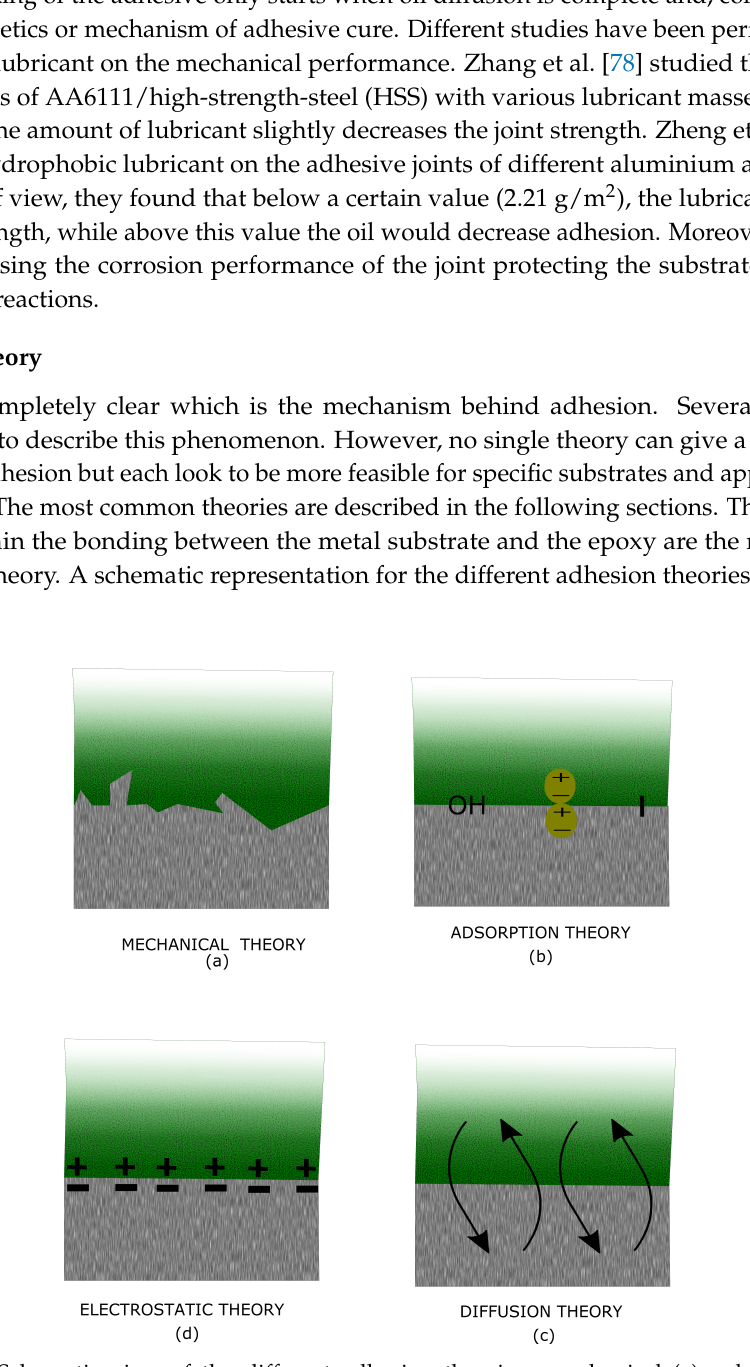
Figure 11. Schematic view of the different adhesion theories: mechanical ( a ), adsorption ( b ), electrostatic ( d ) and diffusion ( c )